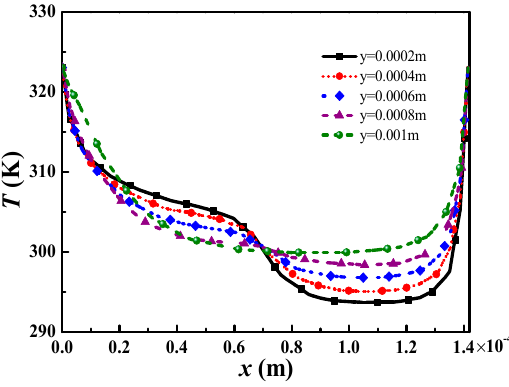
Figure 4. Temperature distribution on the midline of different cross sections along the y -direction.